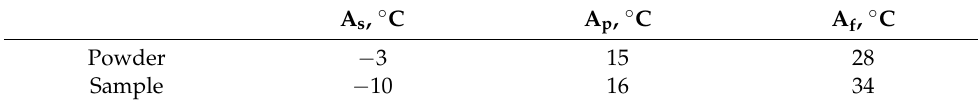
Table 1. Transformation temperatures.